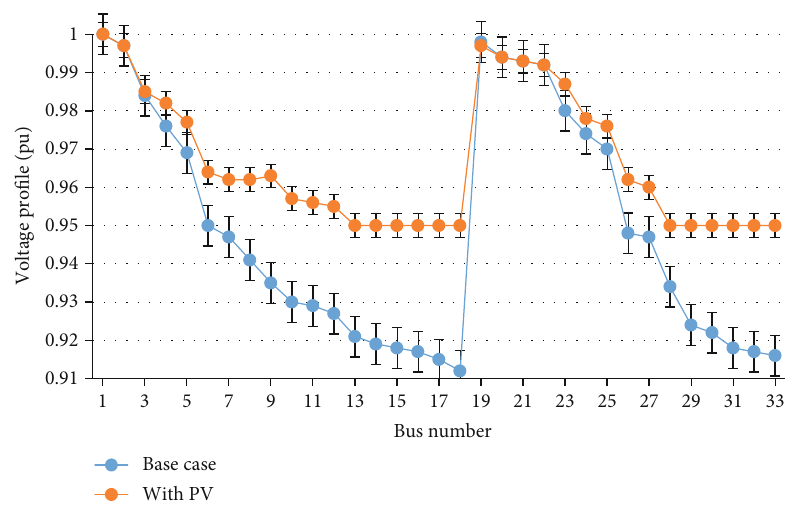
Figure 5: IEEE-33 bus voltage pro fi le before and after PV